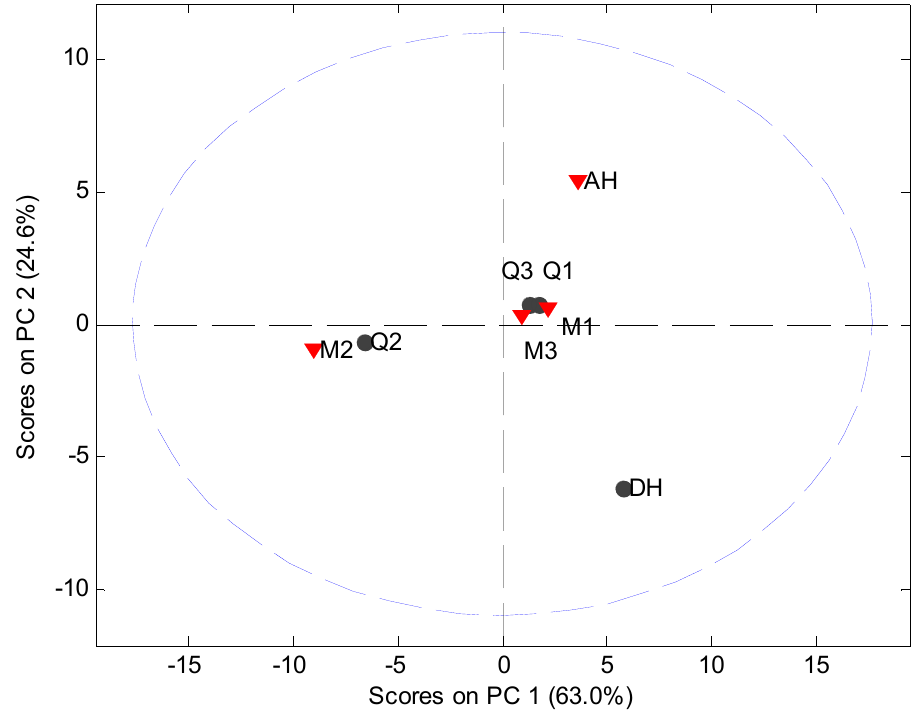
Figure 5. PCA score plot of Raman data (900 cm − 1 to 1800 cm − 1 ). Milled samples (M1, M2 and M3), quench cooled samples (Q1, Q2 and Q3), crystalline anhydrate (AH) and crystalline dihydrate